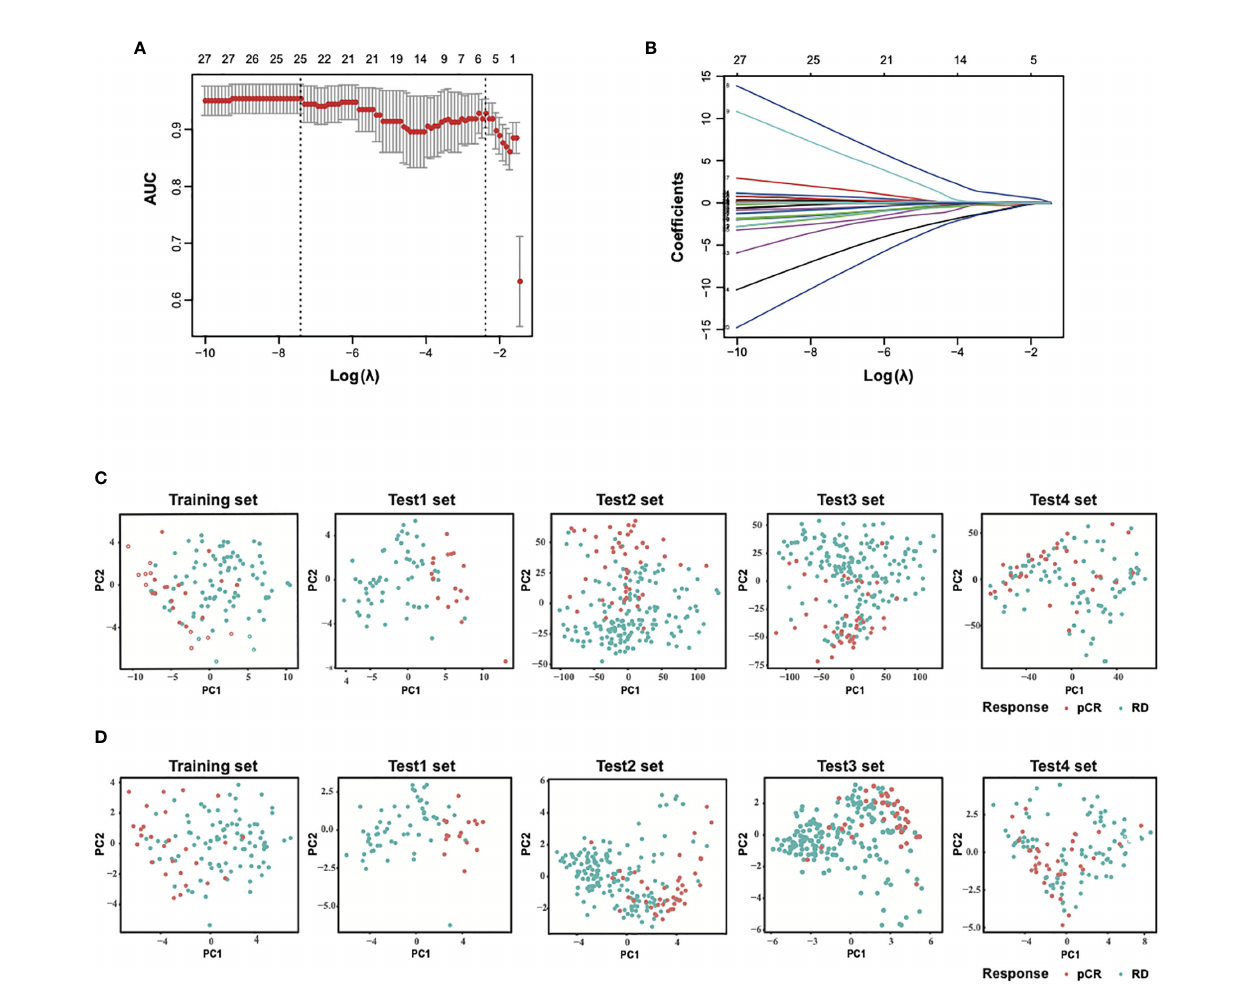
FIGURE 1 | Construction of LASSO model and principal component analysis. (A) Ten-fold cross-validation for tuning parameter selection in the LASSO model. (B) LASSO coef fi cient pro fi les of the training set. (C) PCA before and (D) after LASSO feature selection in the training set and each test sets. LASSO, least absolute shrinkage and selection operator; PCA, principal component analysis. Training set, GSE32646; Test1 set, GSE20271; Test2 set, GSE20194; Test3 set, GSE25055; Test4 set,